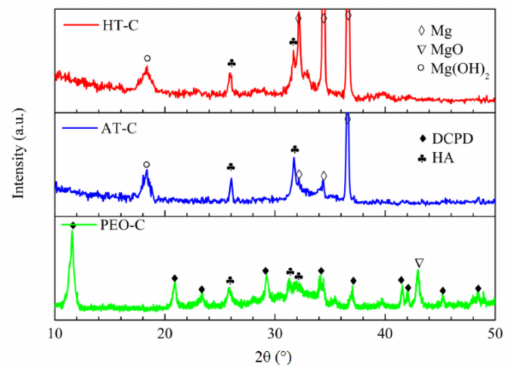
Figure 13. X-ray di ff raction patterns of the CaPh-coated samples after 120 h immersion in SBF at 37 ± 0.5 ◦ C.